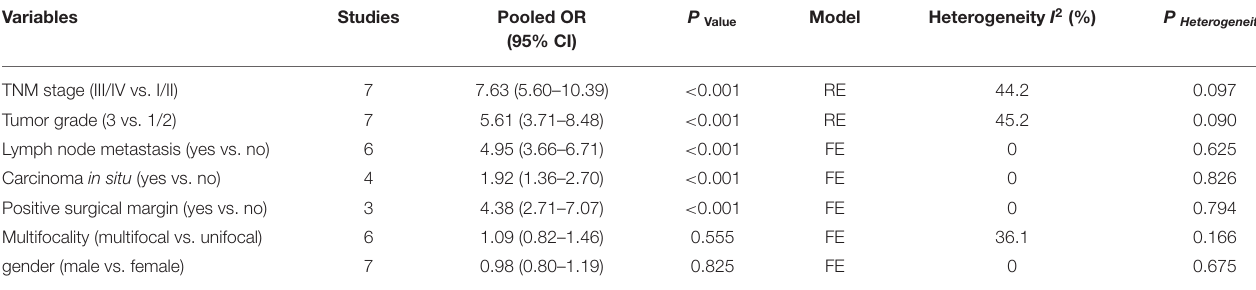
TABLE 4 | Meta-analysis of LVI and clinicopathological features in patients with